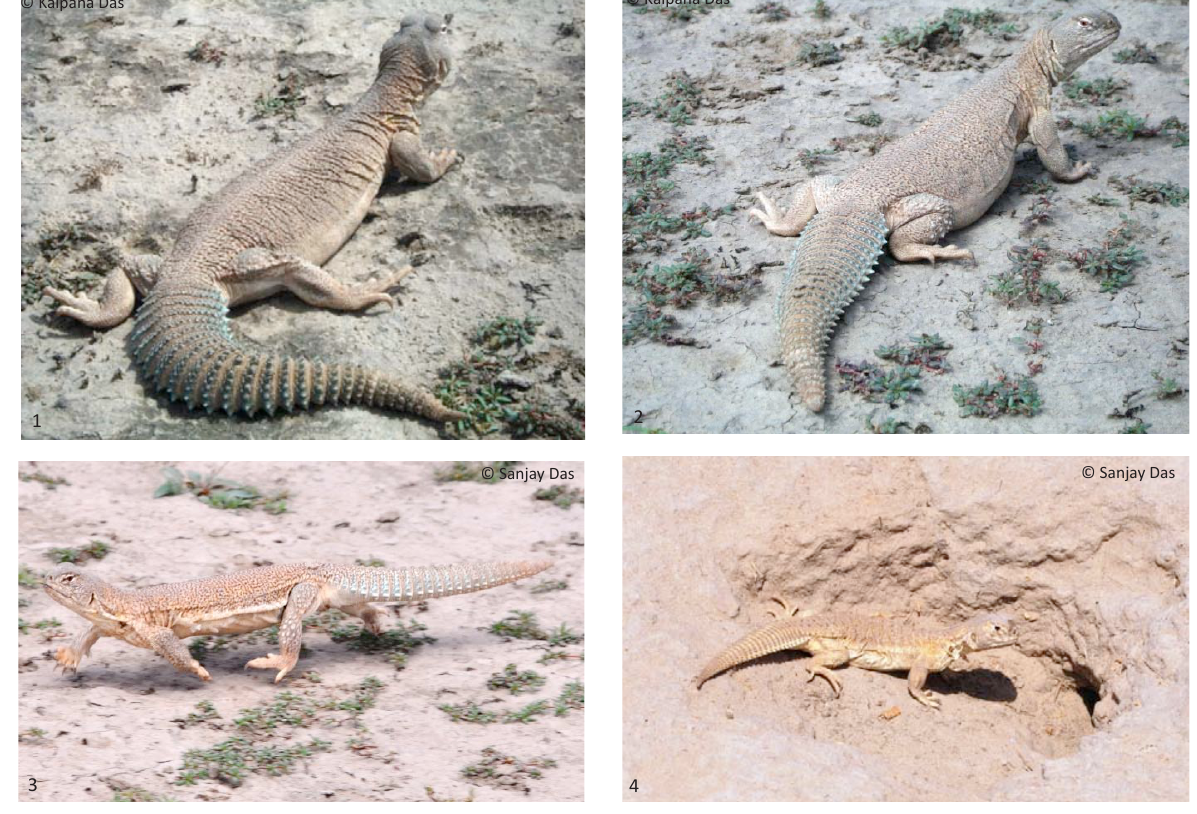
Images 1–4. Indian Spiny-tailed Lizard Saraa hardwickii : 1 - Male; 2 - Female; 3 - Alarmed subadult running with tail above ground; 4 - Juvenile near